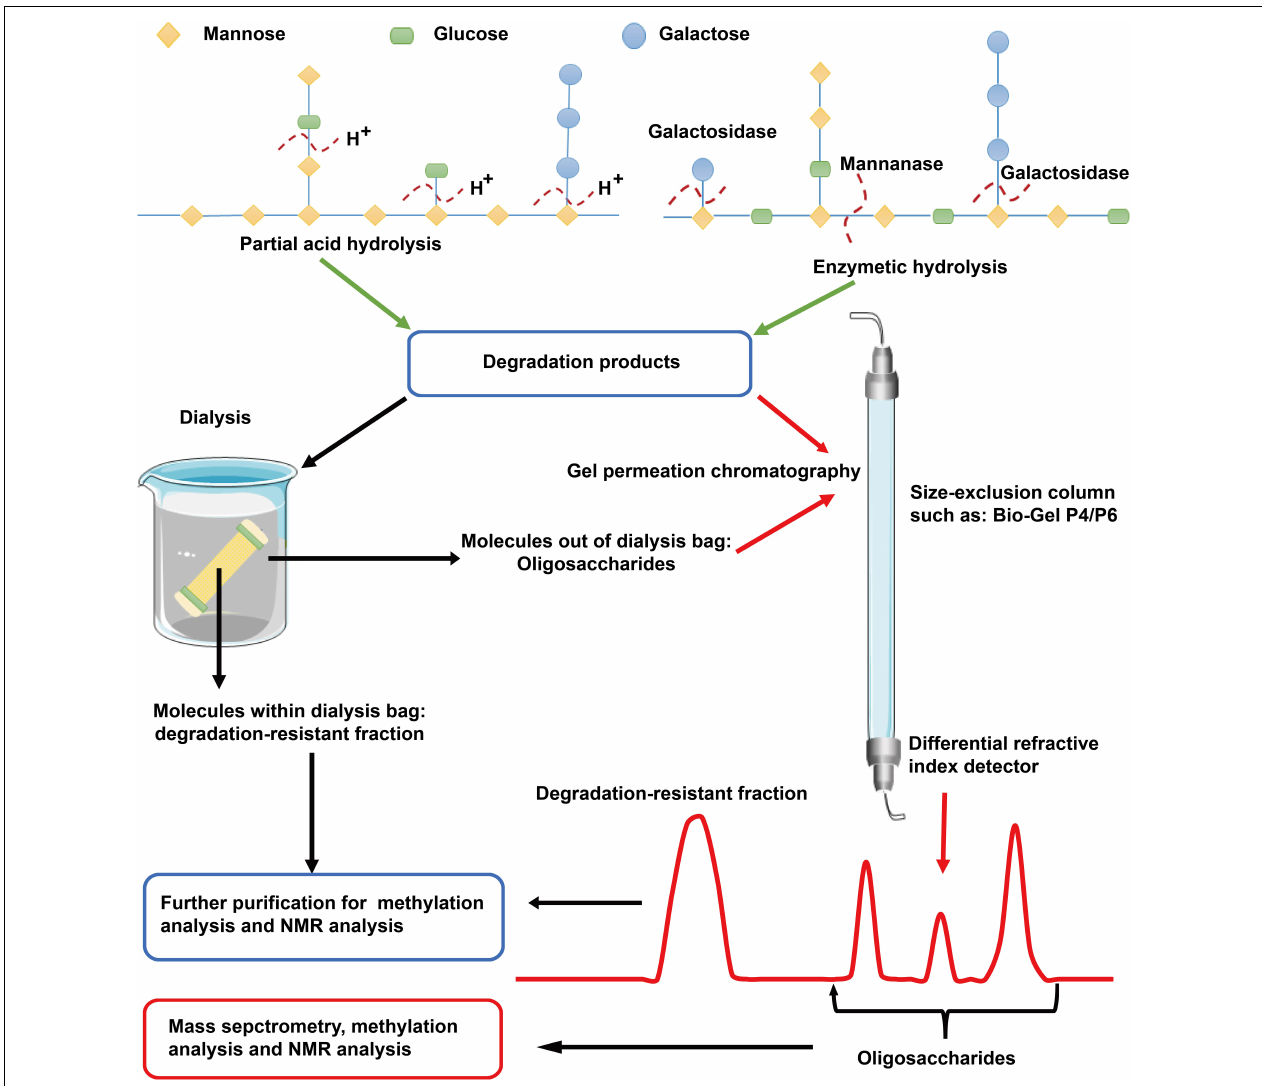
FIGURE 2 | Scheme for elucidation of polysaccharide structure based on degradation. Partial acid hydrolysis with low concentrations of TFA is generally used to remove degradable side chains of polysaccharides. Enzymatic hydrolysis with glycosidase is a more specific method for degradation of glycosyls. The released oligosaccharides and the degradation-resistant fraction can be separated by dialysis using dialysis bags with Mw cutoff < 5.0 kDa or size-exclusion columns such as Bio-Gel P4 or P6. The obtained products can be further analyzed by mass spectrometry, methylation analysis, and NMR experiments. TFA, trifluoroacetic acid; NMR, nuclear magnetic